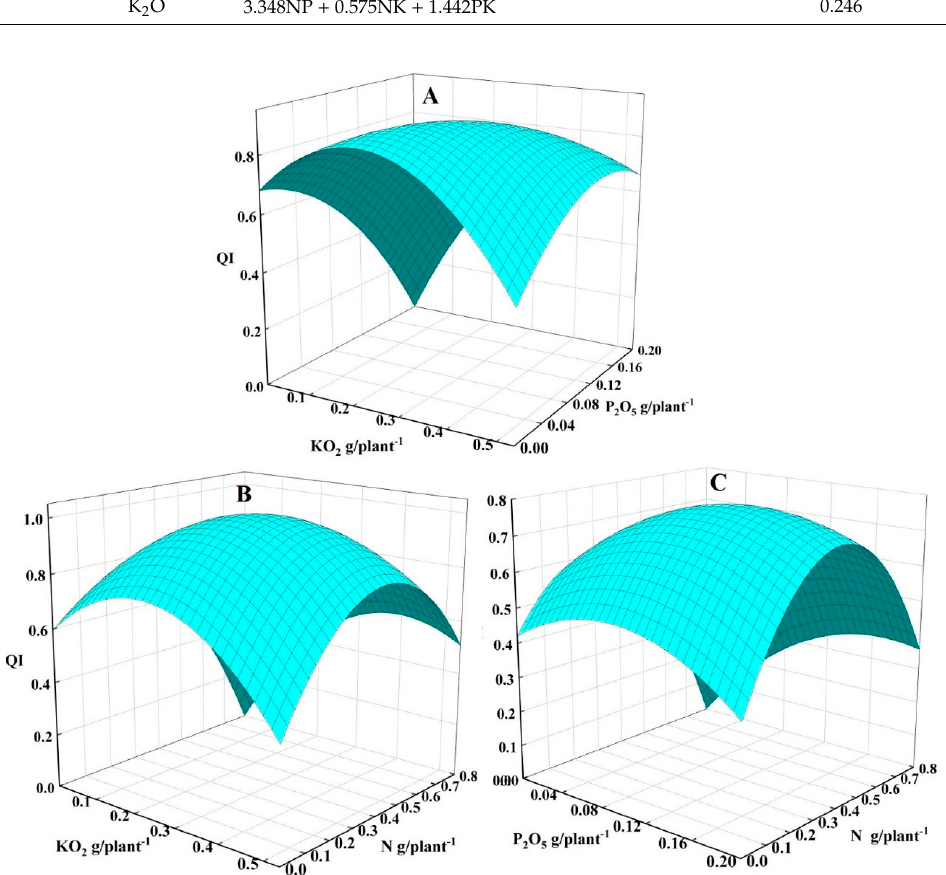
Figure 4. The seedling quality index (QI) for Phoebe bournei seedlings in response to the N, P, and K fertilization interactions of: ( A ) N × P; ( B ) N × K; ( C ) P ×